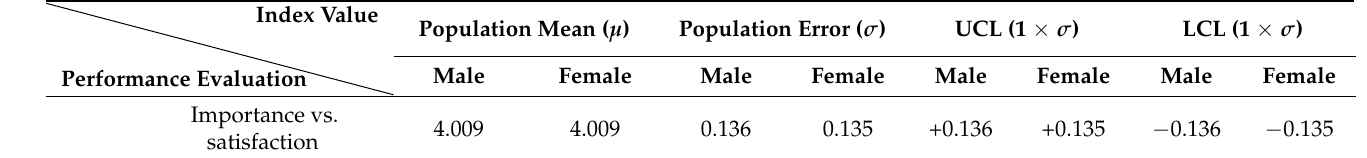
Table 6. Index Values for Gender in the Performance Evaluation Matrix (PEM).